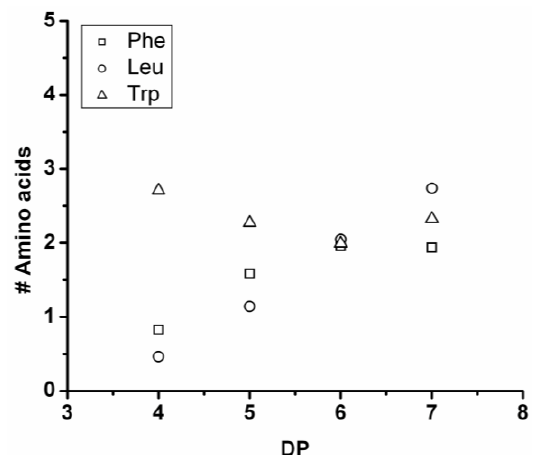
Figure 27. Average amount of amino acids in